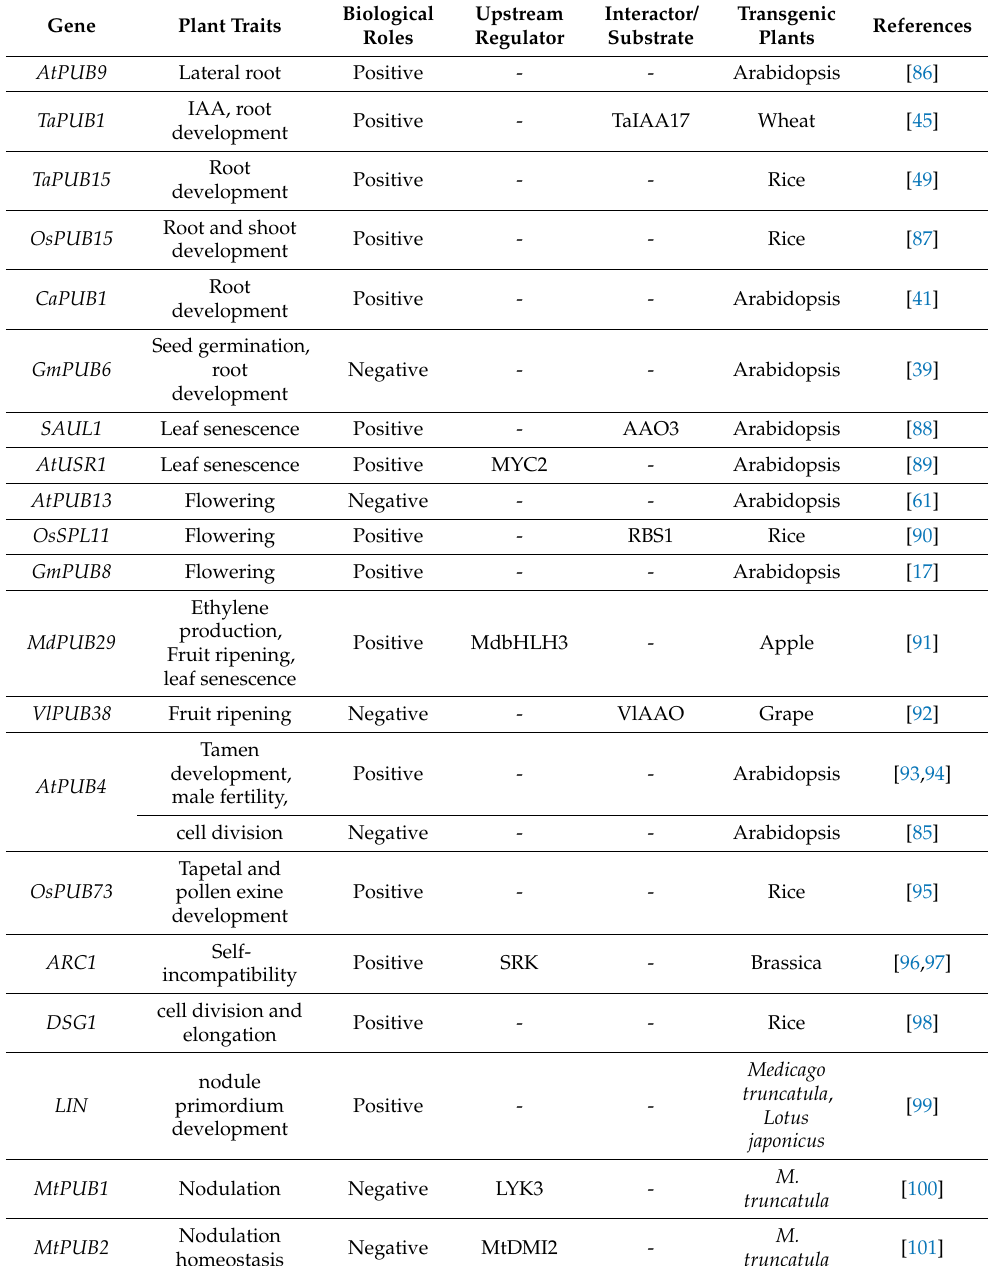
Table 4. PUBs Participate in Plant Growth and